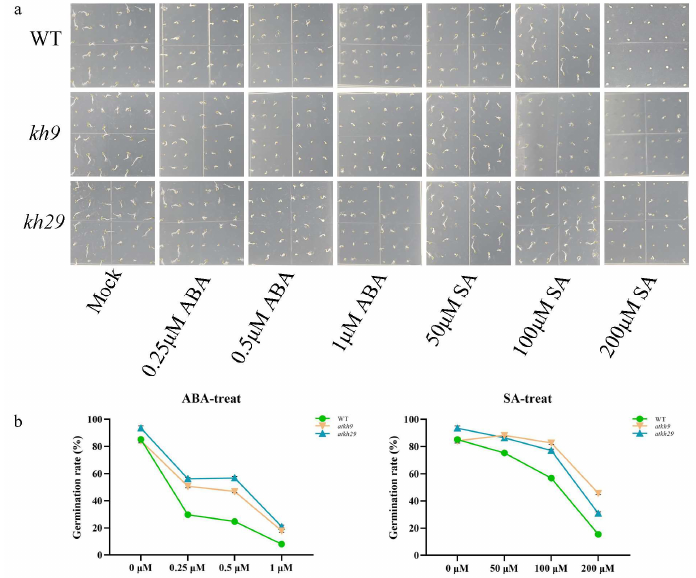
Figure 8. The seed germination rates of atkh9 and atkh29 under ABA and SA treatments. ( a ) Picture of 4 d seedlings of wild-type, atkh9 , and atkh29 on the medium containing 0.25 µ M, 0.5 µ M, 1 µ M ABA, and 50 µ M, 100 µ M, 200 µ M SA. ( b ) Statistics of the germination rates of wild-type, atkh9 and atkh29 . Error bars indicated SD.